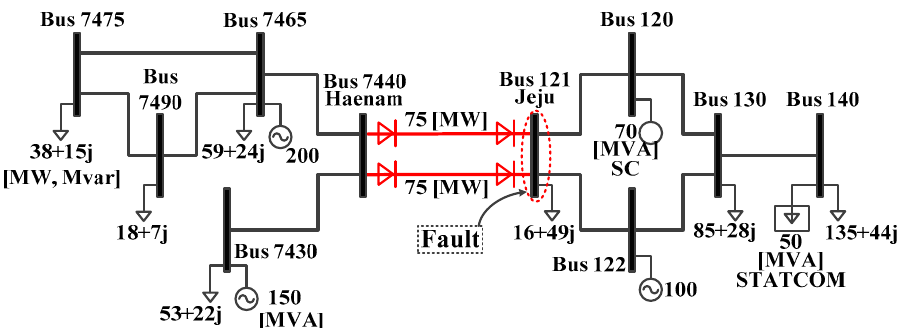
Figure 10. Simplified schematic diagram of the AC network and the Jeju ‐ Haenam HVDC system. Table 5. Detailed parameters of the Jeju–Haenam HVDC system.